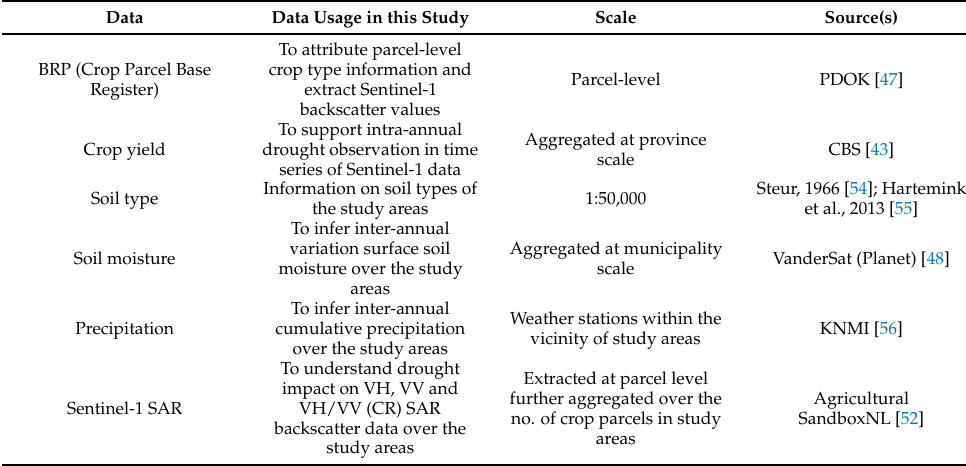
Table 3. Summary of input data used, it’s scale and